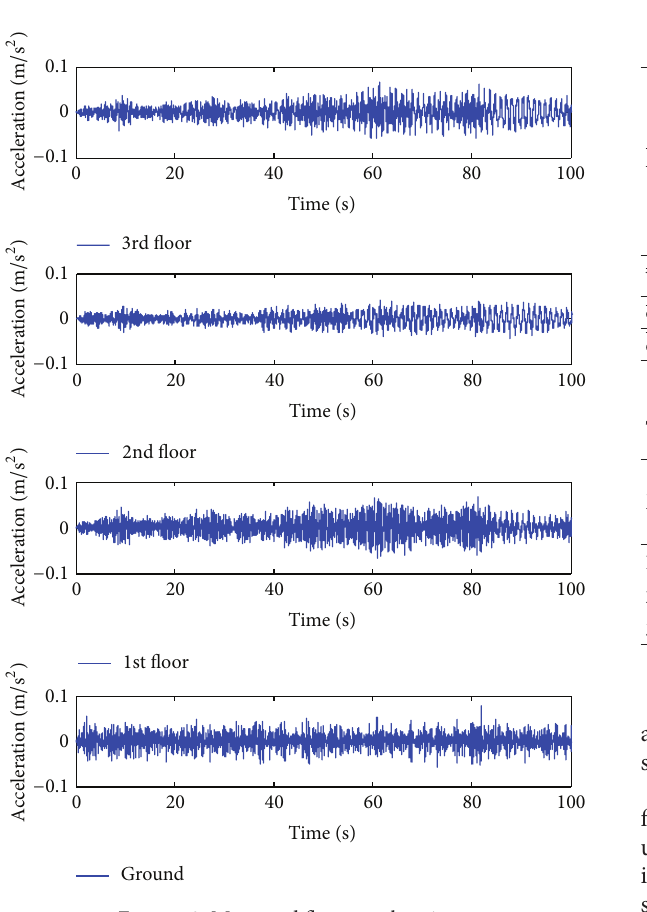
Figure 8: Measured floor accelerations.